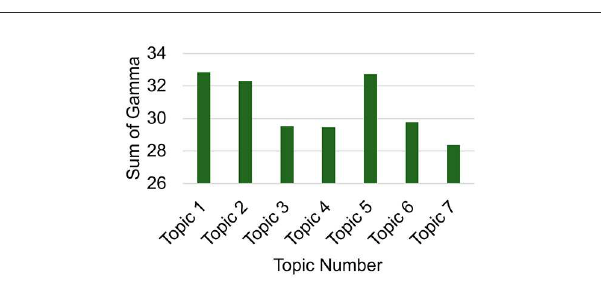
FIGURE7 Per-document-per-topic summation. An indication of the number of articles contributing to each proposed